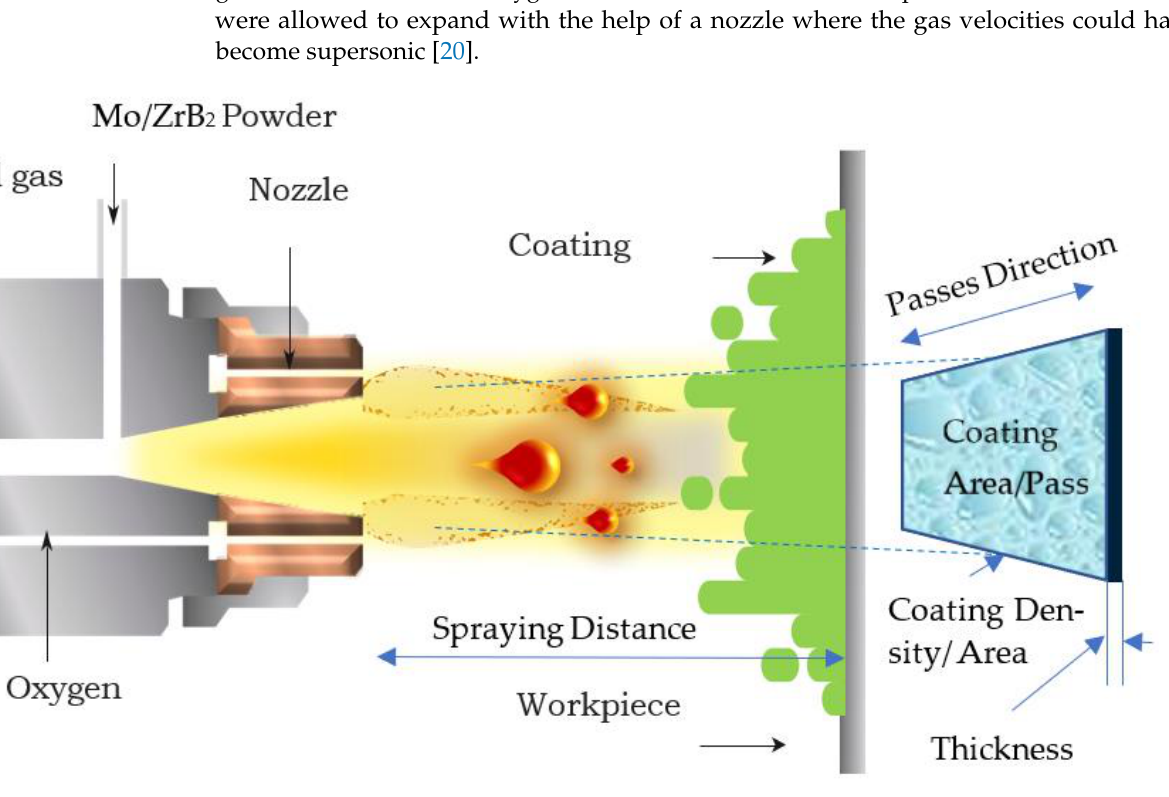
Figure 1. Schematic diagram of the high-velocity oxy spray